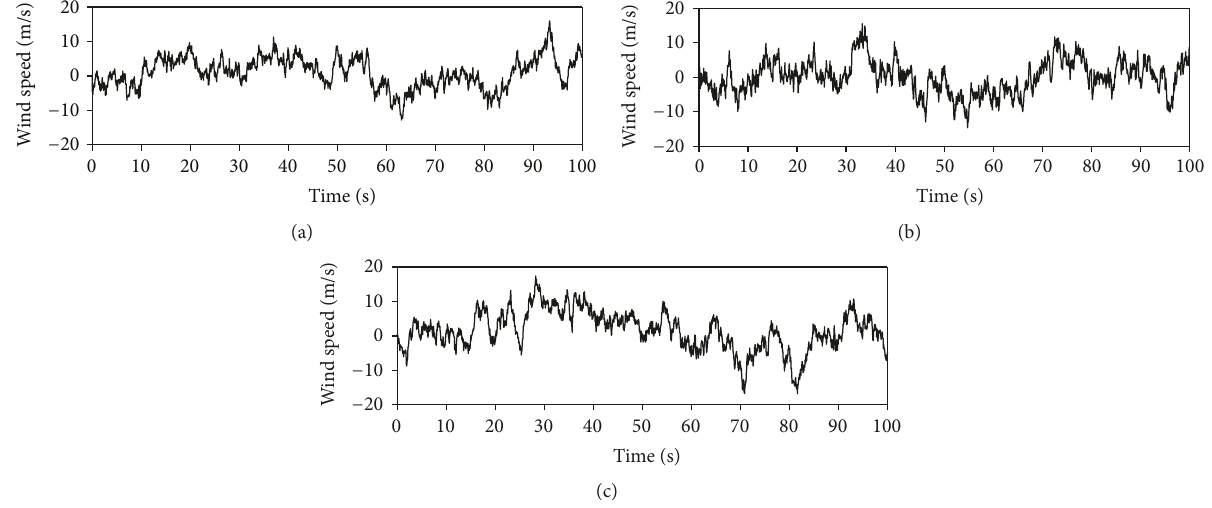
Figure 5: Fluctuating wind speed time histories in regions (a), (b), and (c).